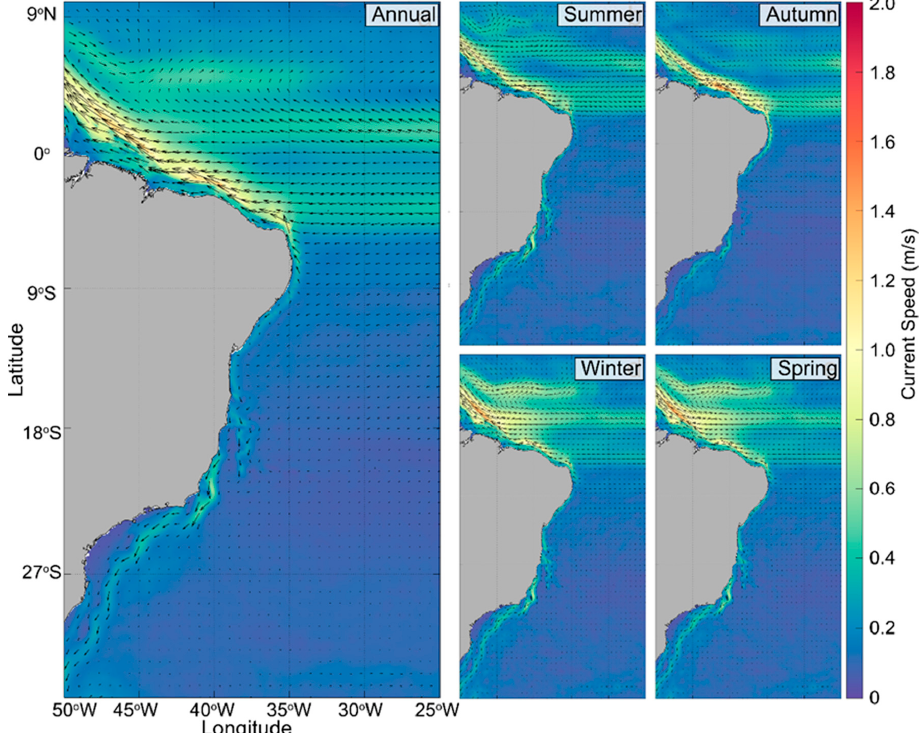
Figure 13. Annual and seasonal (summer, autumn, winter, and spring) mean surface current speed (m/s) at the Brazilian coastline between January 1, 2007 and December 31, 2017.